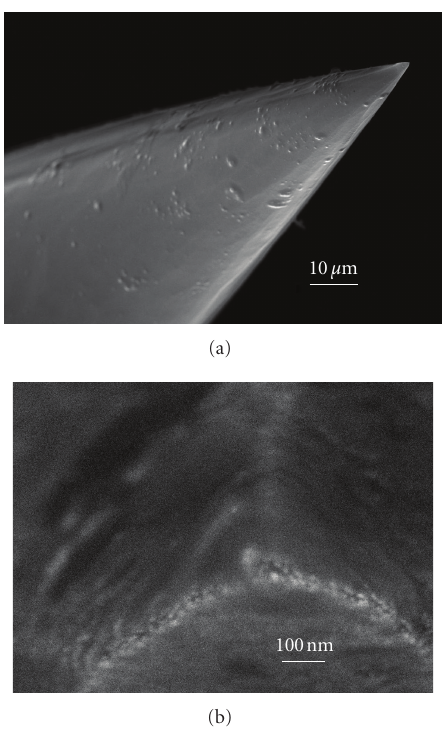
Figure 2: SEM images of tips coated with 15 nm gold nanoparticles: (a) 1300x magnification. (b) 85000x magnification. At this magnifi- cation, nanoparticles on the tip apex can be